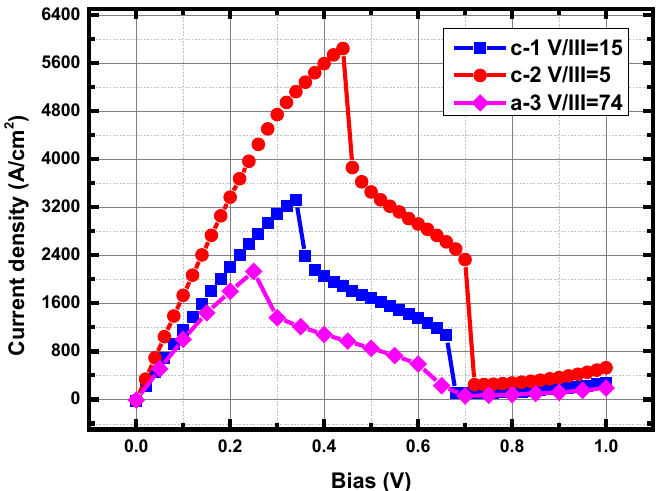
Figure 6. Experimental results of tunnel-junction devices under various V / III ratio for the In 0.07 GaAs layer.